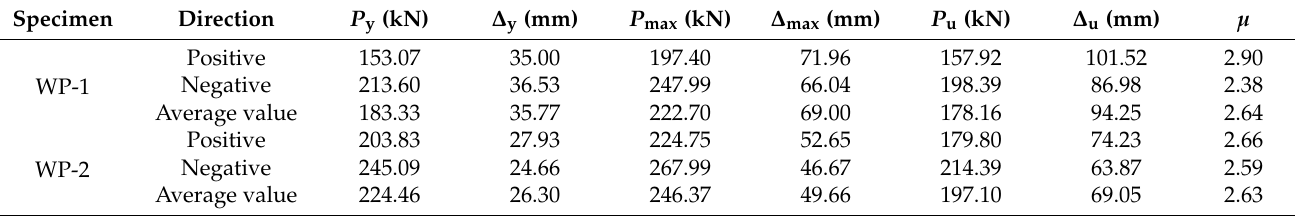
Table 4. The characteristic values.